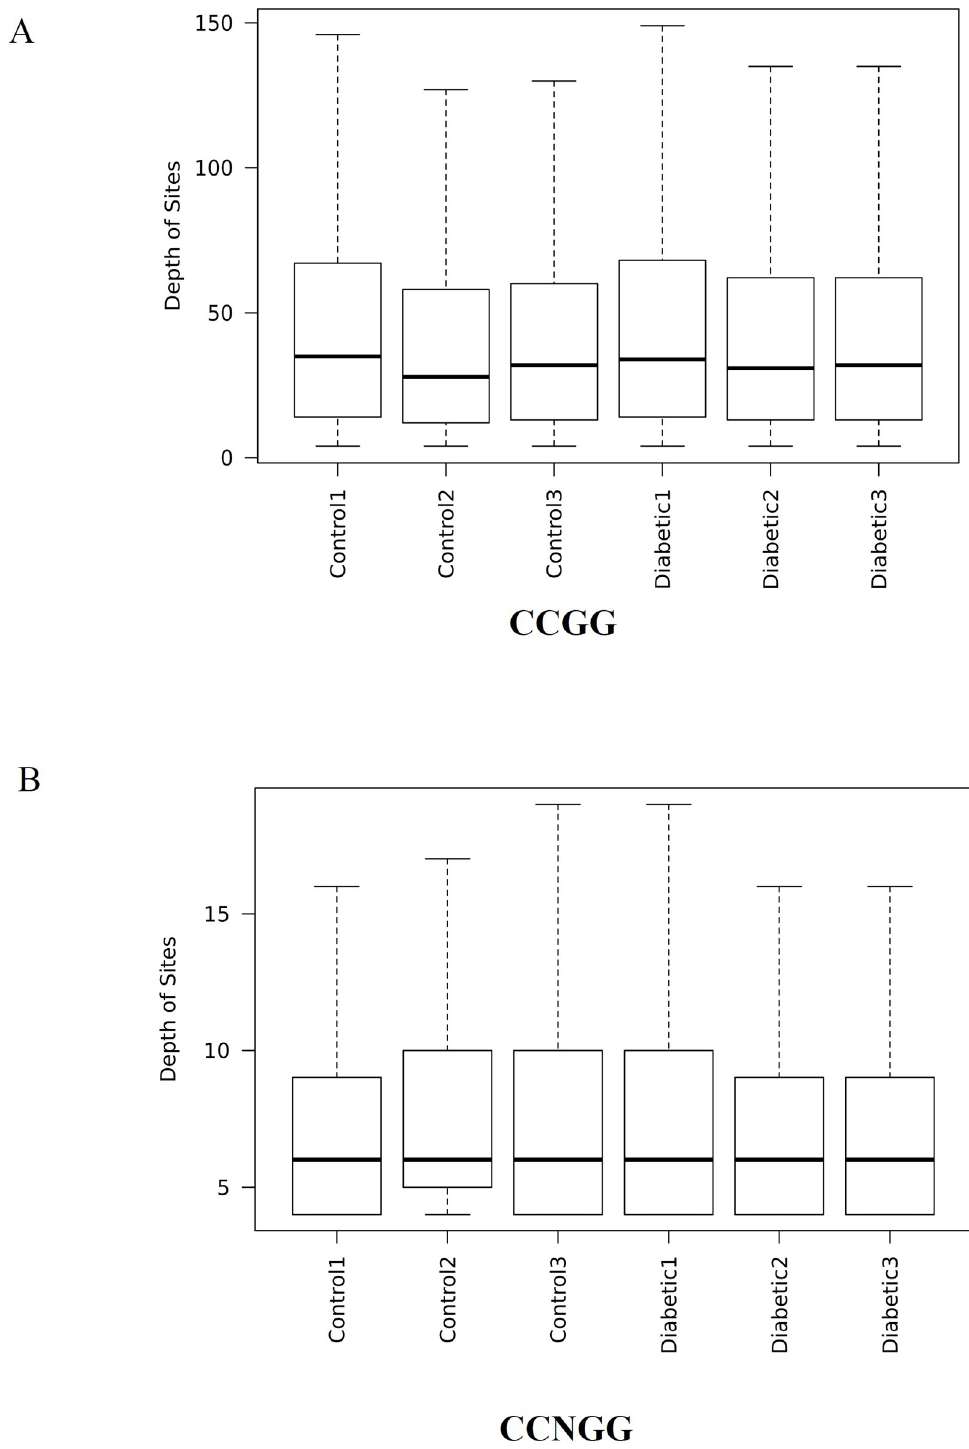
Fig 1. The sequencing depths of the DNA methylation sites (CCGG sites and CCNGG sites) in each sample are shown in a box plot. (A) Sequencing depth box diagram of CCGG methylation site in each sample. (B) Sequencing depth box diagram of CCNGG methylation site in each sample. In the box diagram, the box part is the main body of the box- shaped chart, and the middle of the black horizontal line is the median of the data.